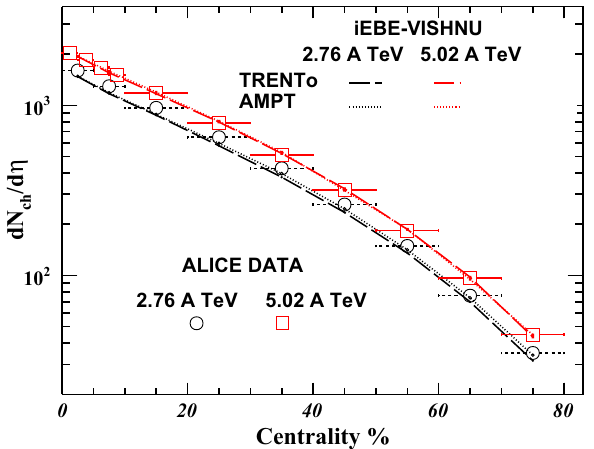
Fig. 2 The centrality dependence of the charged-hadron multiplicity density d N ch / d η ( | η | < 0 . 5) in Pb + Pb collisions at 2.76 and 5.02 A TeV, calculated from iEBE-VISHNU with TRENTo and AMPT initial conditions. The experimental data are taken from [71,72],